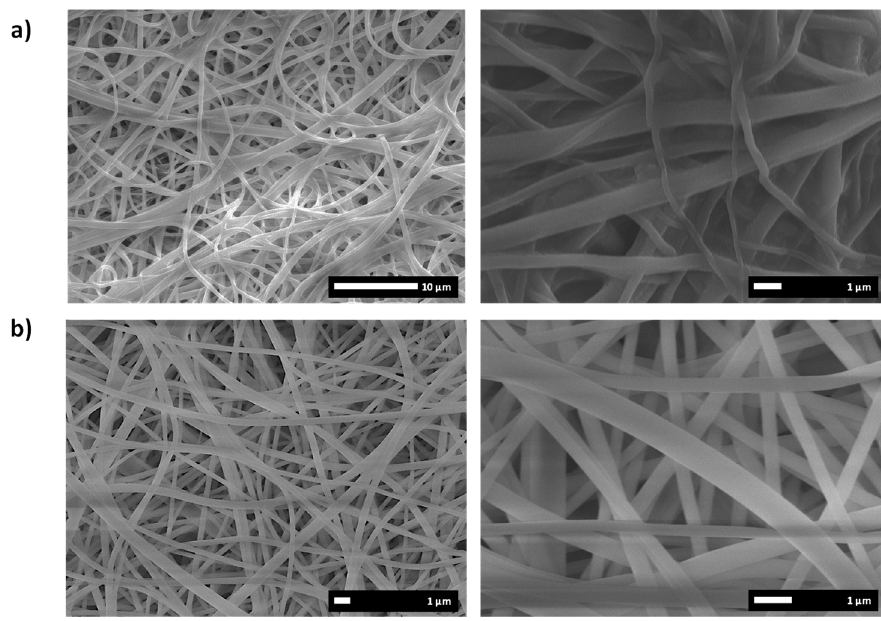
Figure 7. Sem pictures for the polymeric mats ( a ) Mat 9 (scale bars correspond to left: 10 μ m, right: 1 μ m) ( b ) Mat 10 (scale bars correspond to 1 μ m).